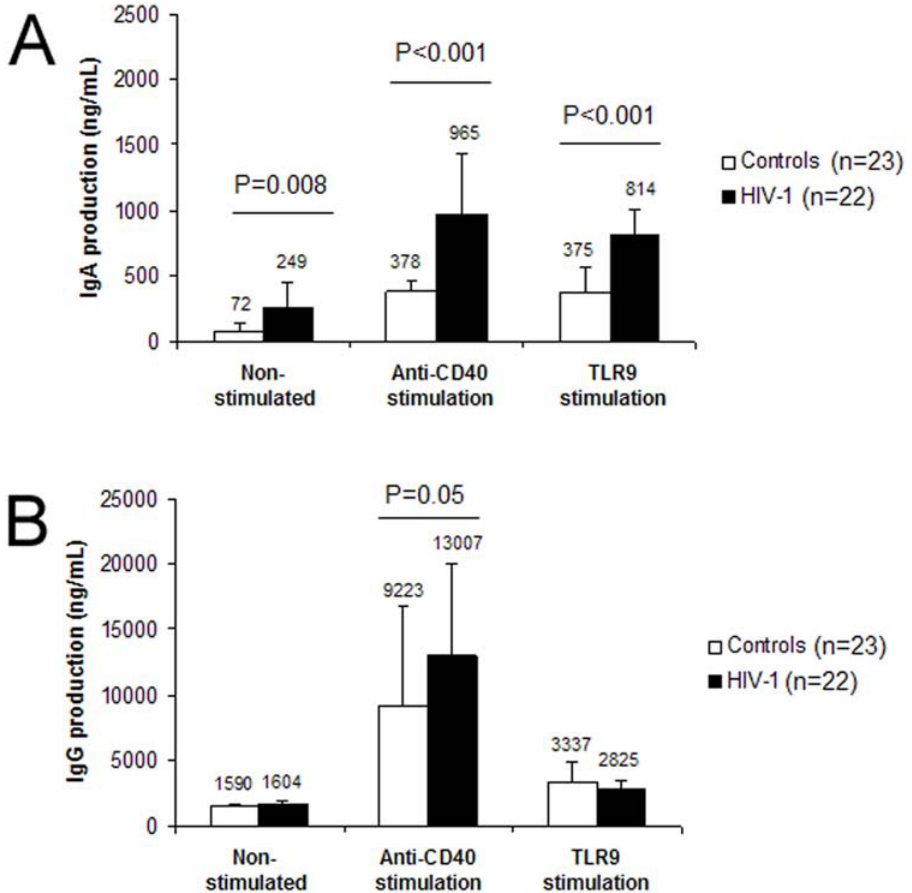
Figure 2. IgA and IgG production invitro in HIV-1 infected patients and healthy controls. (A) The levels of IgA before (left panel) and after in vitro stimulation (anti-CD40 mAb, IL4 and IL10 or CpG, middle and right panels) are higher in patients (black bars) as compared with controls (white bars). (B) The levels of IgG before (left panel) and after in vitro stimulation (middle and right panels) are similar in patients (black bars) as compared with controls (white bars).